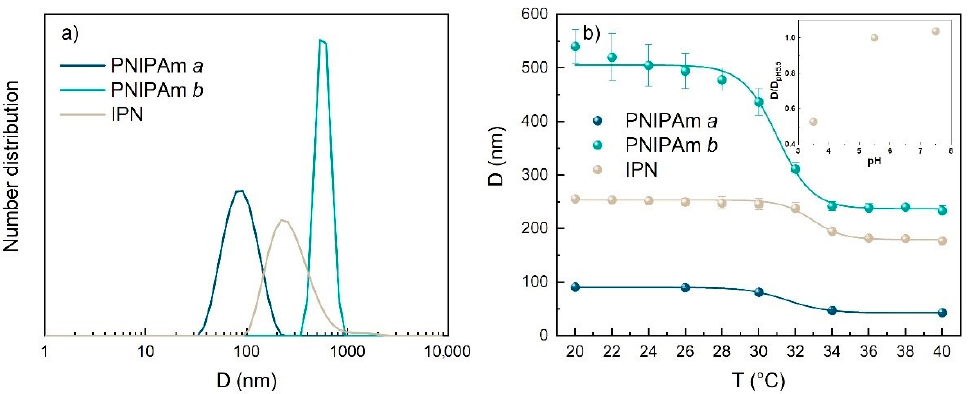
Figure 1. Dynamic light scattering measurements of PNIPAm a , PNIPAm b and IPN: ( a ) number distributions versus the hydrodynamic diameter measured at 20 °C; ( b ) hydrodynamic diameter versus temperature. In the inset in ( b ), ratio between the diameter at a given pH to the one at pH 5.5 as a function of pH. The concentration of the measured dispersions was 0.01 wt%.